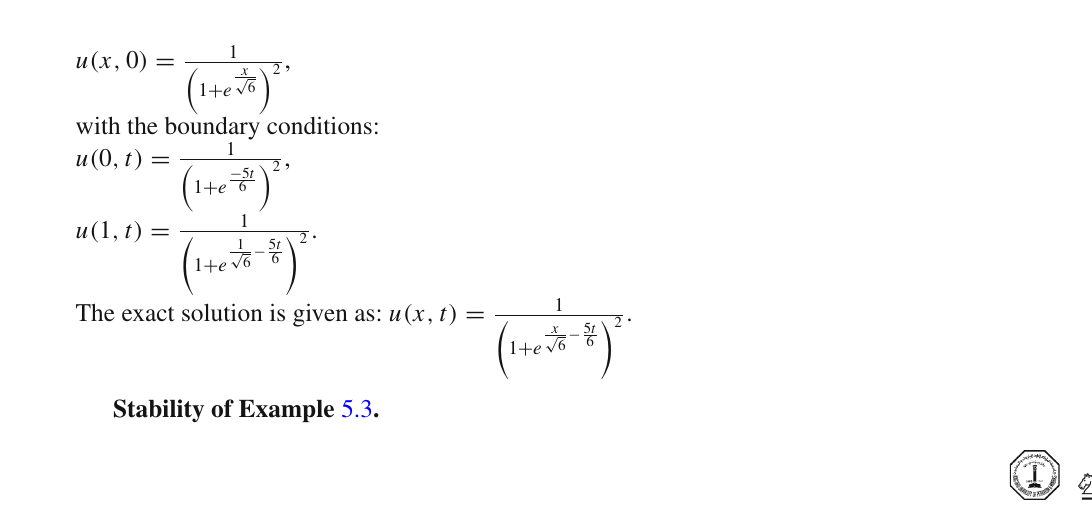
Fig. 4 I-EFD solution of Example 5.2 for (cid:2) t = 0 . 05 and (cid:2) x = 0 .